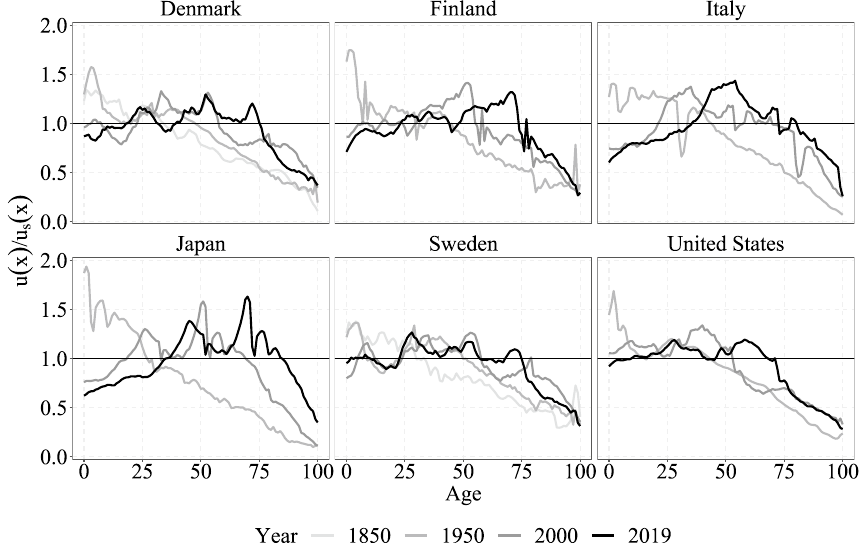
Fig. 8 Ratio of the age distributions of the observed and stationary population in 6 countries from HMD,